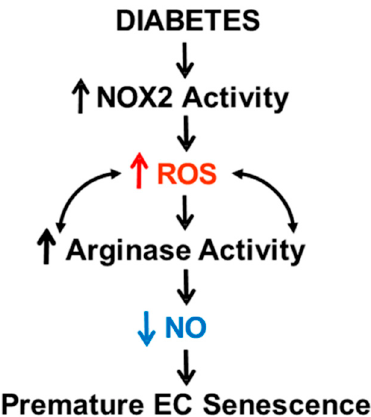
Figure 11. Hypothesis: Diabetes-induced activation of NOX2/NADPH oxidase promotes the development of premature endothelial cell senescence by a mechanism involving ROS-induced activation of arginase which amplifies ROS and decreases bioavailable NO. Figure S1: Diabetes induces an increase in NOX2 expression. Western blot and quantitation showing effects of diabetes in increasing NOX2 expression. * p < 0.05, n = 4. Figure S2: NOX2 deletion prevents